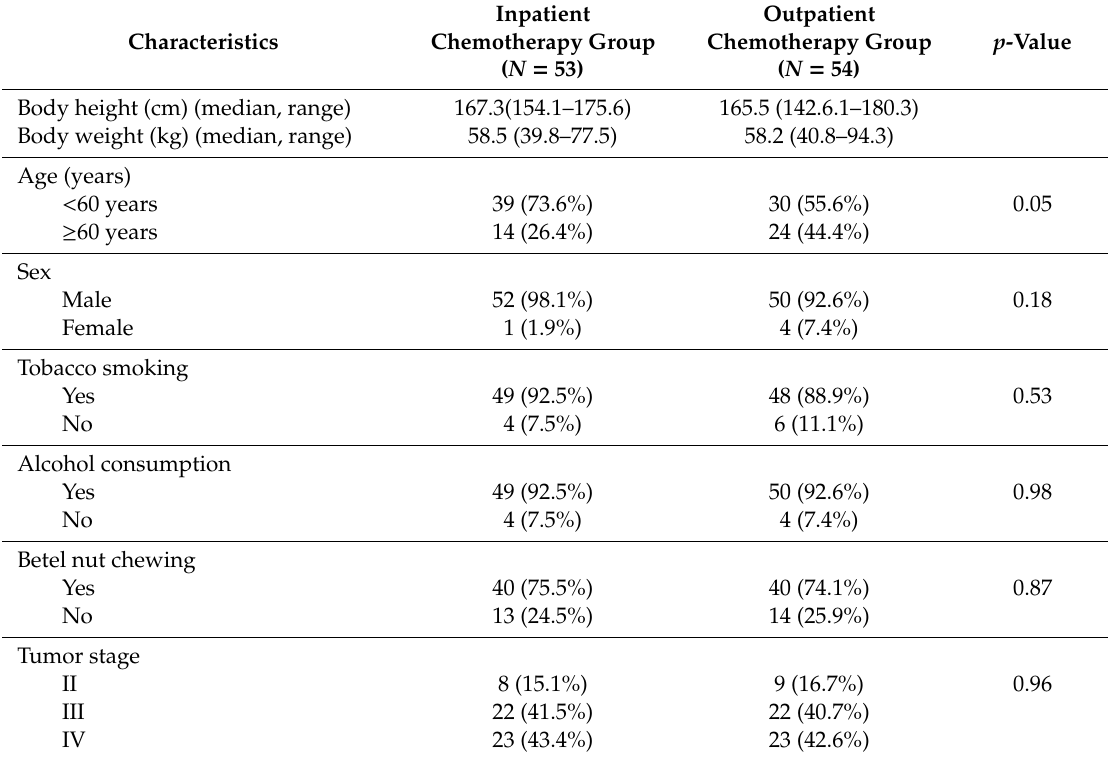
Table 1. Characteristics of the 107 patients with esophageal squamous cell carcinoma who received inpatient or outpatient